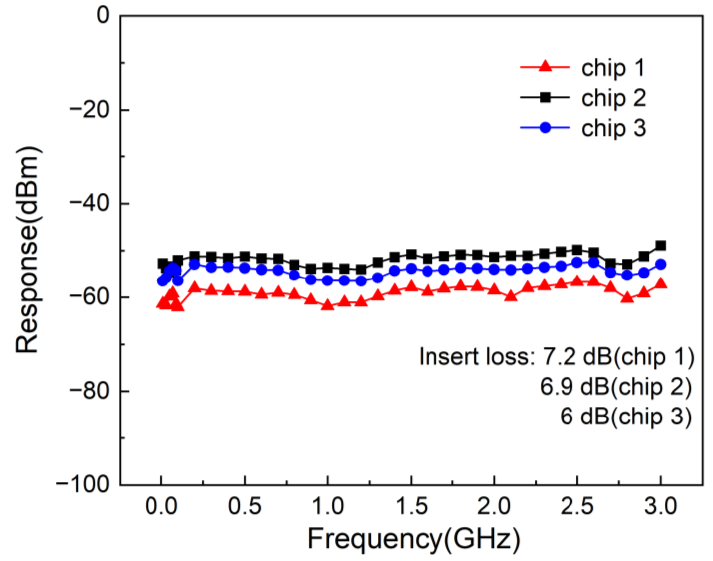
Figure 6. Frequency response and optical insertion loss of the three sensor chips in the 3D sensor.